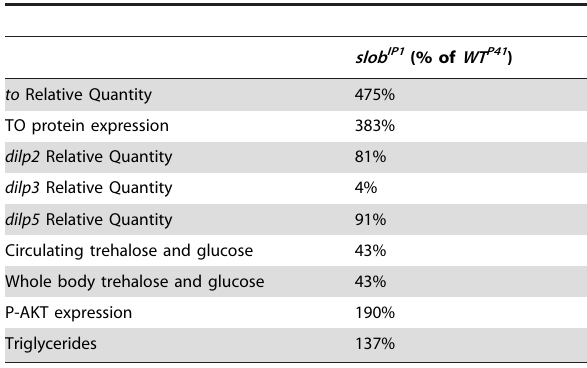
Table 1. Measures of gene expression and metabolism in slob IP1 flies, expressed as a percentage of WT P41 control